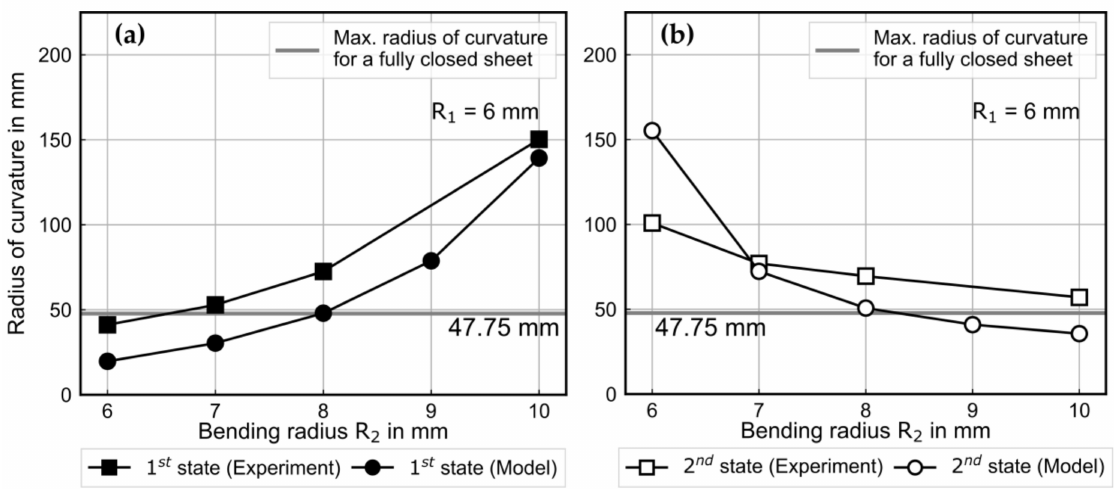
Figure 12. Radii of curvature for first ( a ) and second ( b ) stable state after first bending operation with a radius R 1 = 6 mm and various second bending radii R 2 .